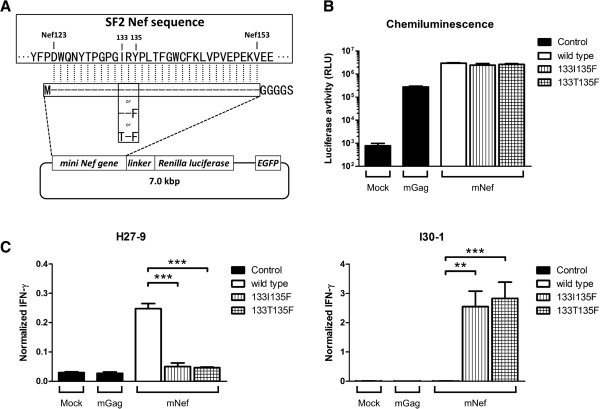
Recognition of endogenously derived epitope. (A) Vector construction. The vector expresses EGFP as a transfection marker and a fusion protein that consists of mini-Nef gene coding 31 amino acids of Nef123-Nef153 region and GlyGlyGlyGlySer linker and renilla luciferase. The 133I/135F and 133T/135F mutant vectors as well as wild type vector were constructed. Mini-Nef sequence that corresponds to the actual Nef gene is shown. (B) By measuring luciferase activity, quantity of the generated mini-Nef was assessed. No significant differences in mini-Nef generation between wild type, 135F and 133T/135F were observed. Each stick and bar indicates average and standard deviation of three independent experiments. (C) The vector transfected cells were incubated with either H27-9 or I30-1, and IFN-γ secretion was quantified by ELISA and normalized to determine the epitope recognition. For normalization, each value was divided by IFN-γ secretion with wild type peptide concentration of 9 μM. Mock as well as mGag, transfected with mGag(wt)-hRluc-EGFP, were measured as negative controls. Each stick and bar indicates average and standard deviation of three independent experiments. The significance was calculated by unpaired Student’s t-test; **, p < 0.01; ***, p < 0.001.